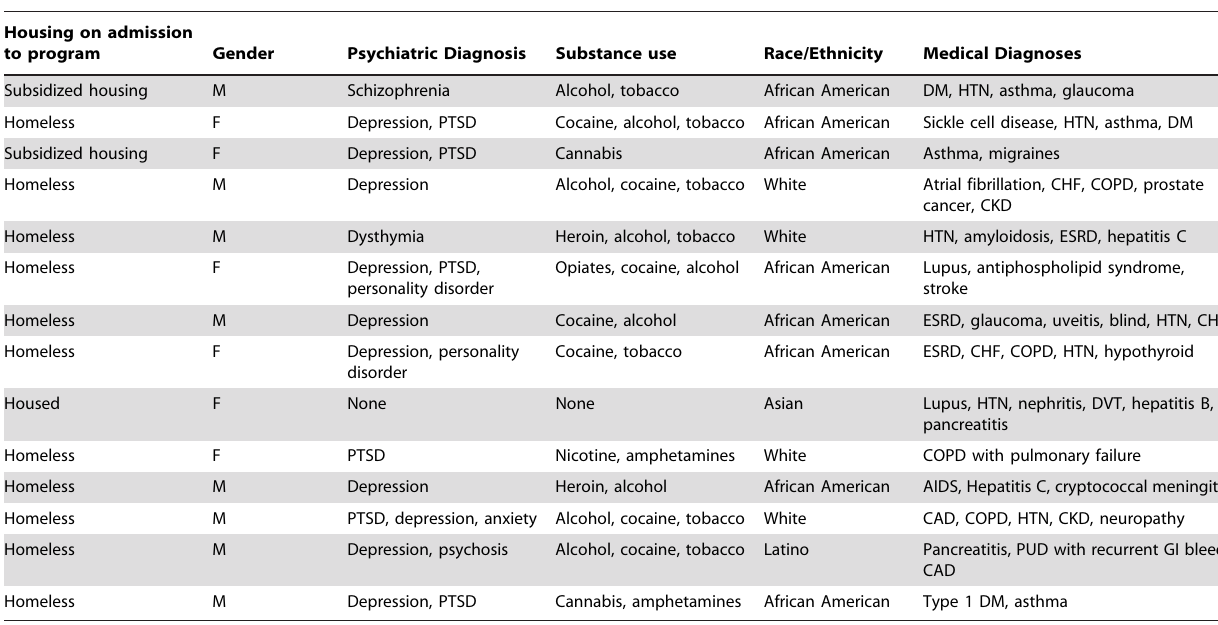
Table 2. Participant